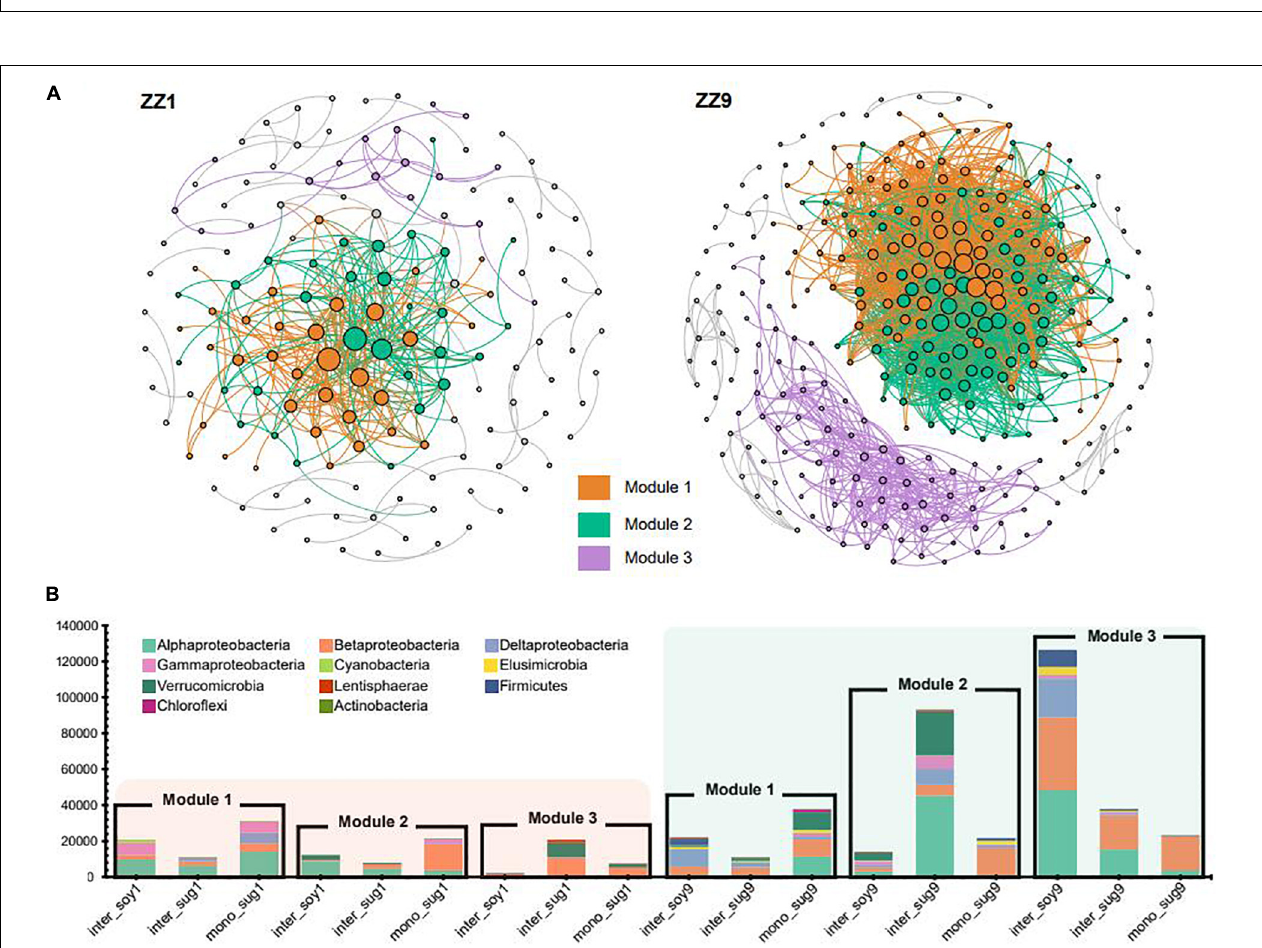
FIGURE 5 | (A) Significant correlation of co-occurrence network visualization ( ρ > 0.7, P < 0.001; In ZZ1 and ZZ9 communities, bacterial ASVs were represented by a gray line. Dots represent an ASV, and ASVs are colored according to their association with different cropping systems (gray ASVs are insensitive to variety differences). The size of the dots reflects the association between ASVs and other ASVs, and the more associated ASVs the larger the dots are (B) cumulative relative abundance in different cropping systems, and different colors represent different phyla.